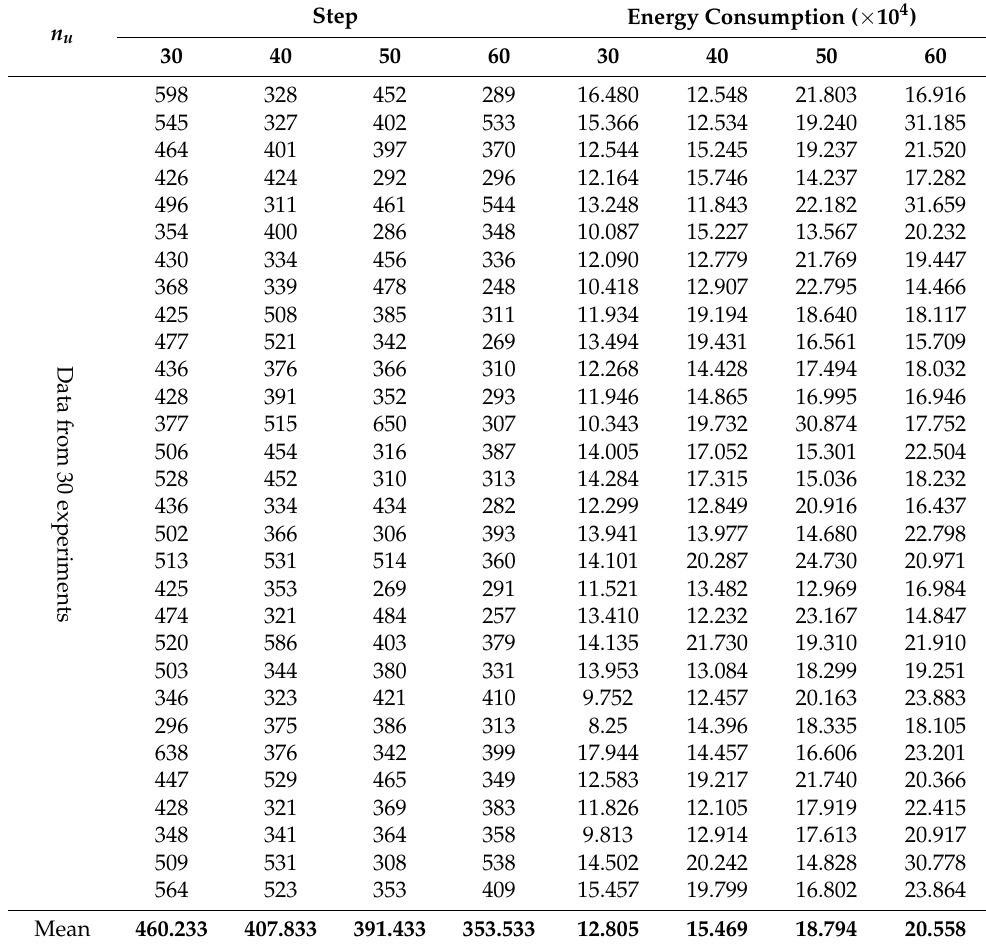
Table 4. Target n T = 10 and mountain slope greater than β : the number of steps and energy consump- tion required for the robots to complete the task